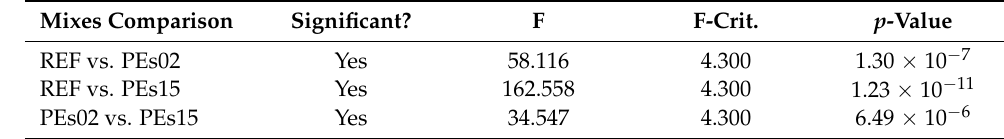
Table 8. The results of the ANOVA performed on the measured IT-CY stiffness moduli. Mixes